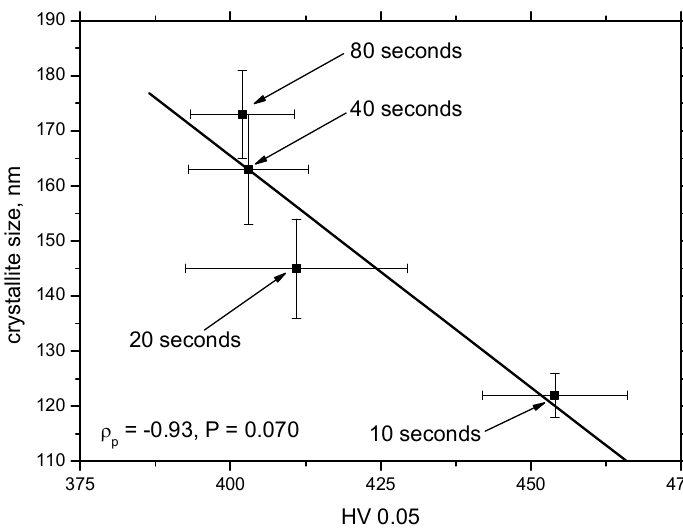
Figure 13. Surface microhardness versus crystallite size.